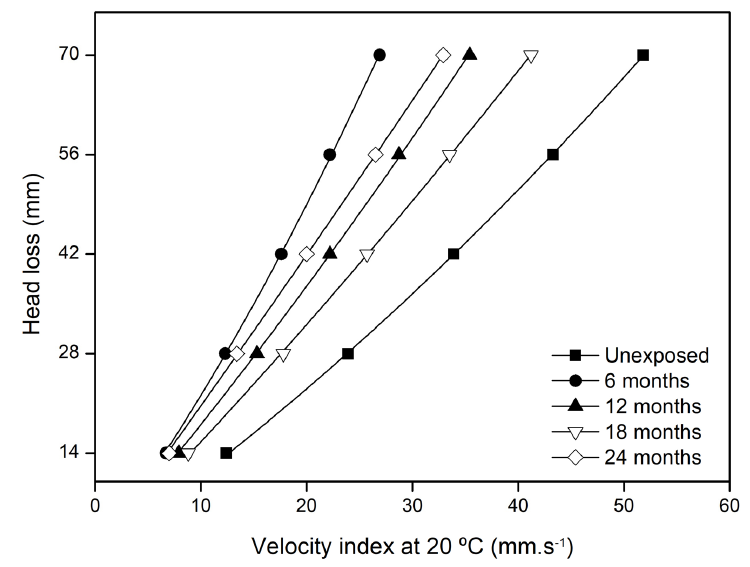
Figure 3. Reduction (in percentage) of mechanical strength over time. (Notation: T—tensile strength; F R —tearing strength; F P —puncture strength).